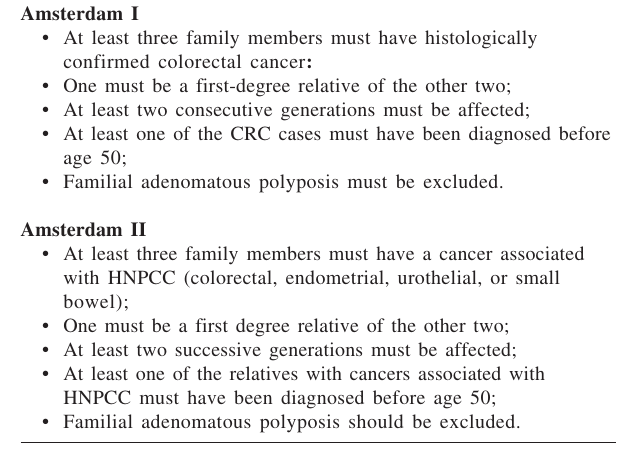
Table 1 - Amsterdam criteria I and II 16